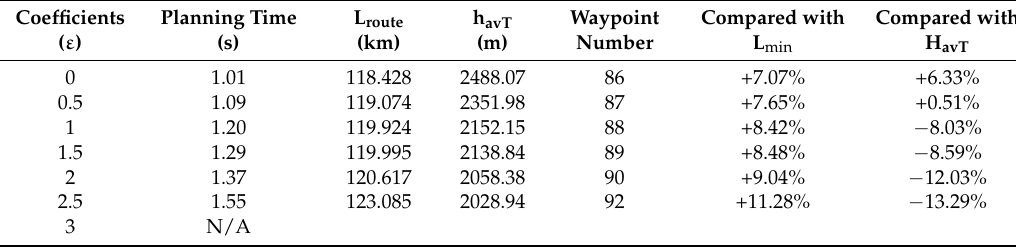
Table 3. Comparison results for different coefficients.